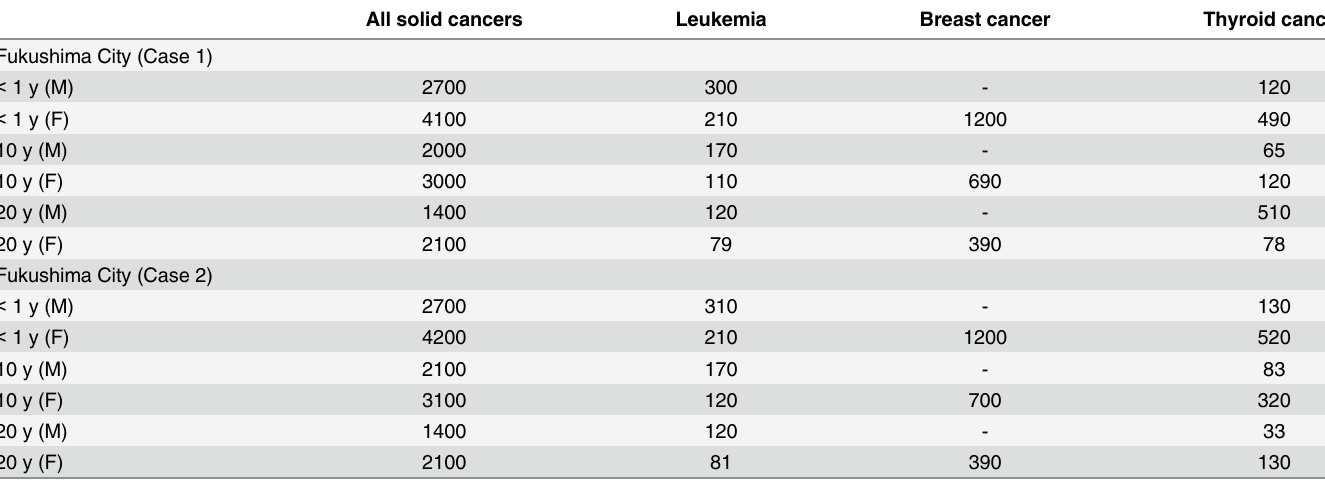
Table 4. LARs for all solid cancers, leukemia, breast cancer, and thyroid cancer (×10 − 6 ) due to external exposure, inhalation, and ingestion. All solid